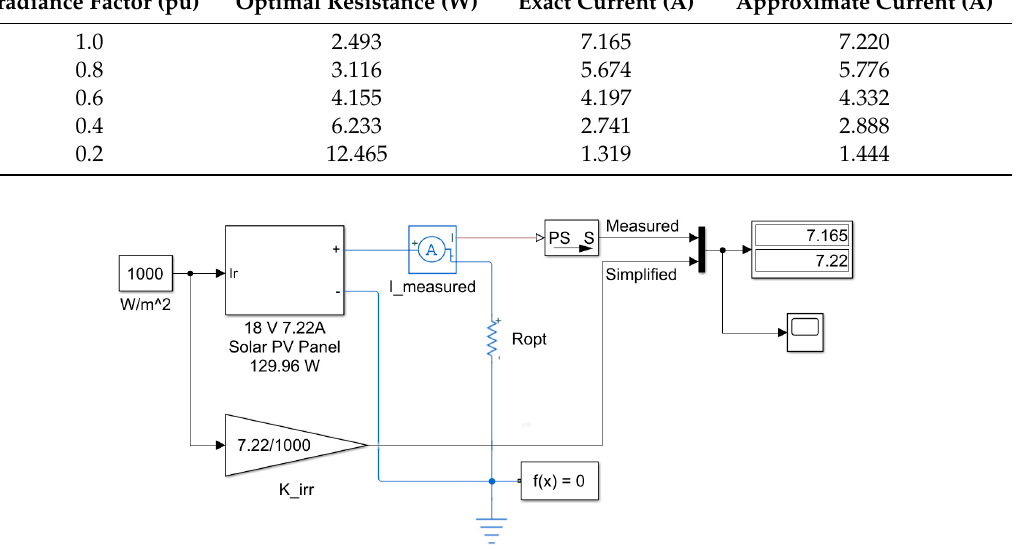
Table 1. Photovoltaic (PV) panel characteristics.